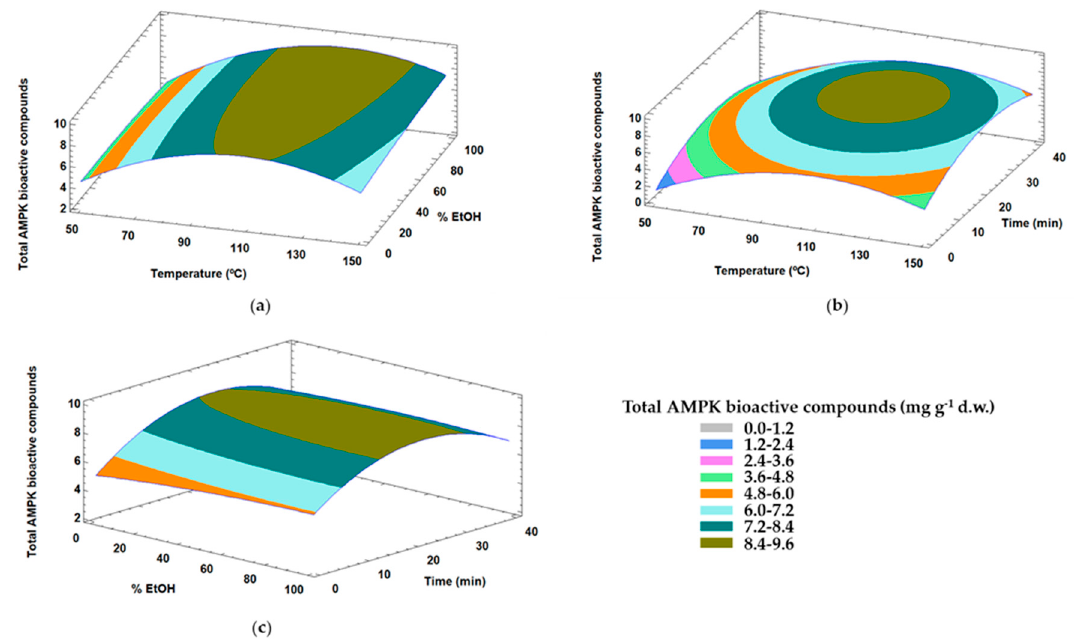
Figure 3. Response surface plots showing combined effects of process variables for total AMPK bioactive compounds: Temperature (°C)–% EtOH ( a ), temperature (°C)–time (min) ( b ) and % EtOH– time (min) ( c ).